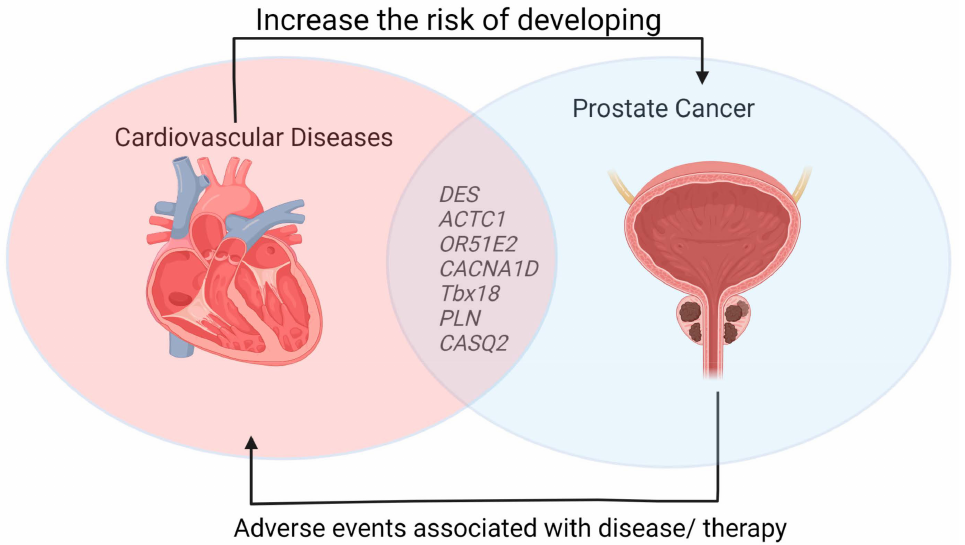
Figure 3. A molecular link between prostate cancer and cardiovascular diseases (Created by